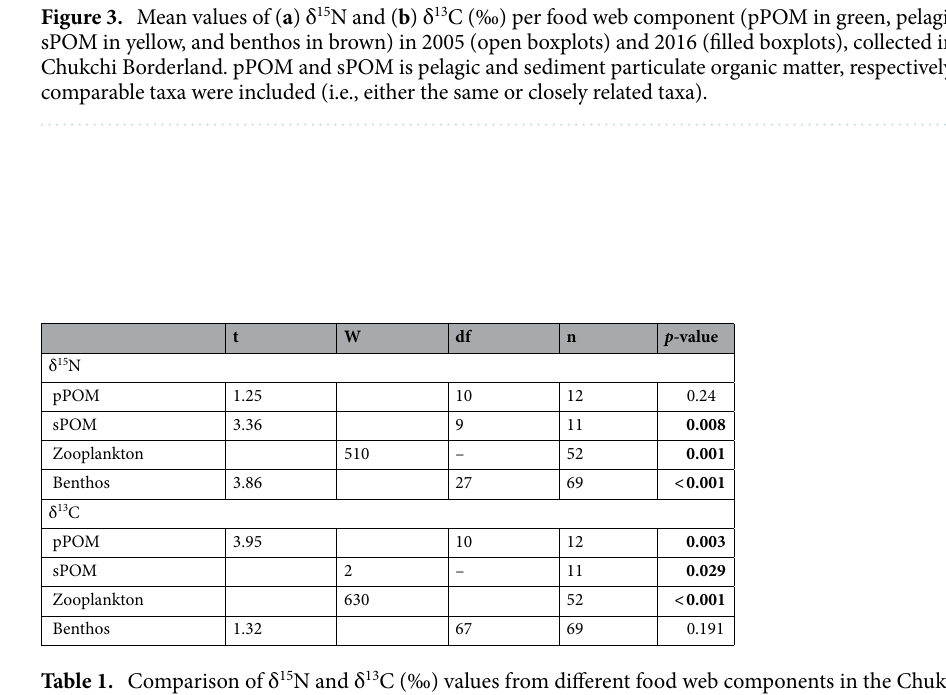
Table 1. Comparison of δ 15 N and δ 13 C (‰) values from different food web components in the Chukchi Borderland between 2005 and 2016: results of parametric two sample t -test (t), Welch’s two sample t -test (t) and Wilcoxon rank sum test (W) (for choice of test see methods). Numbers in bold indicate statistically significant results ( p values < 0.05). See Table 3 for pPOM and sPOM abbreviations. See Fig. 4 for graphical representation of means and